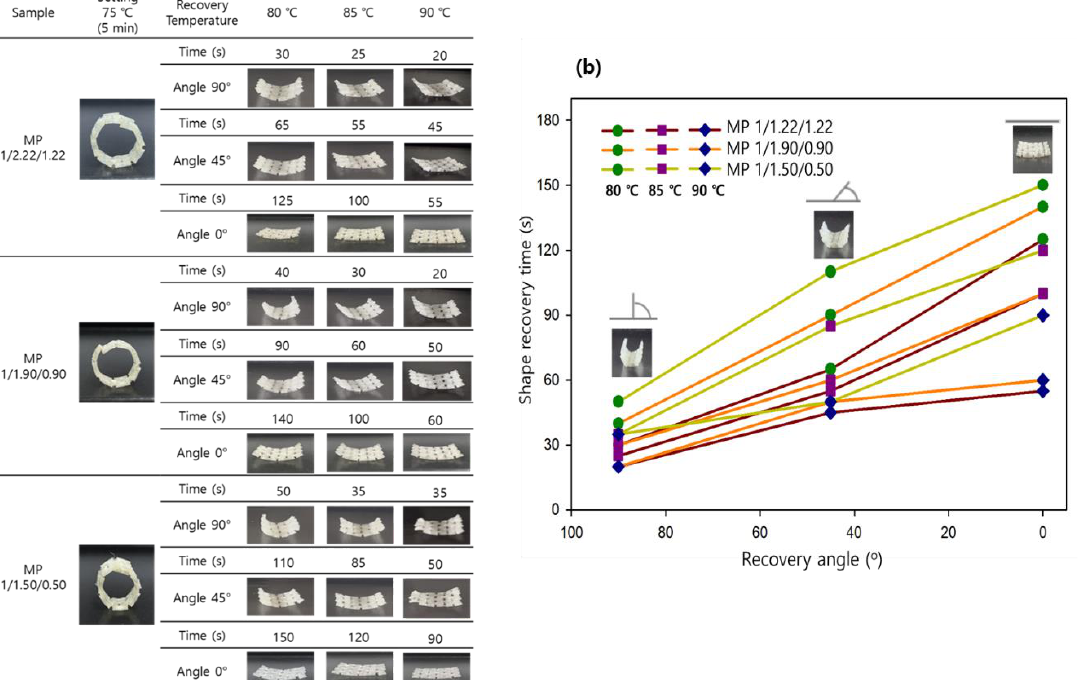
Figure 11. ( a ) Photographic images showing the shape memory behaviors of the auxetic re-entrant SMTPU samples subjected to different recovery temperatures. ( b ) Plot of the shape recovery time versus the recovery angle under different recovery temperature conditions (i.e., 80, 85, and 90 °C) for the 3D-printed re-entrants.